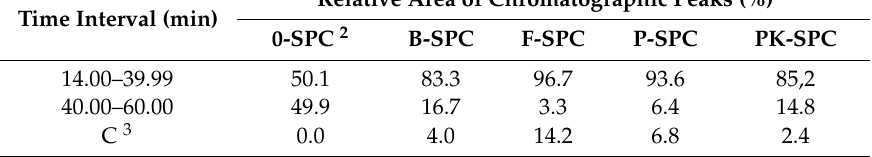
Table 2. Results of soybean protein hydrolysis as revealed by RP-HPLC (Reversed-Phase High Performance Liquid